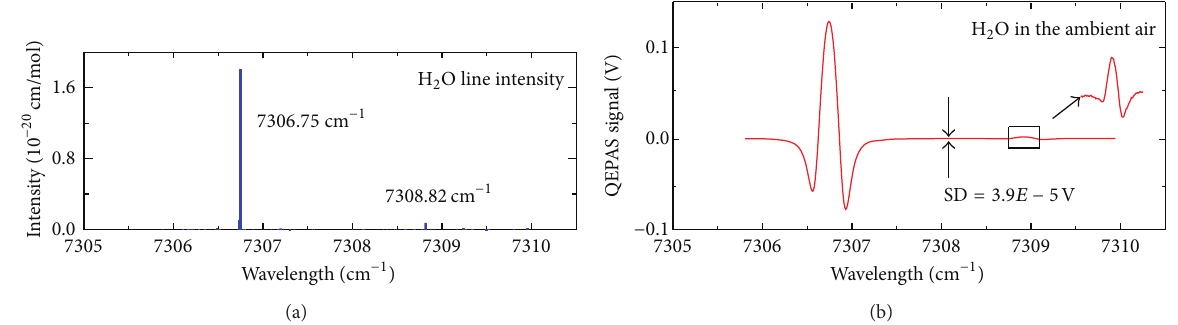
Figure 3: (a) Locations and intensities of H 2 O absorption lines from the HITRAN database; (b) 2𝑓 signal obtained from the QEPAS sensor by use of a single bare QTF based spectrophone; SD: standard deviation.